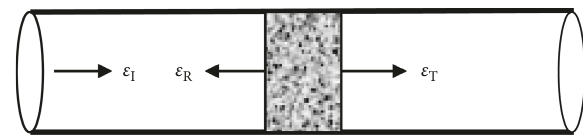
Figure 6: Schematic illustration of the dynamic test under partial